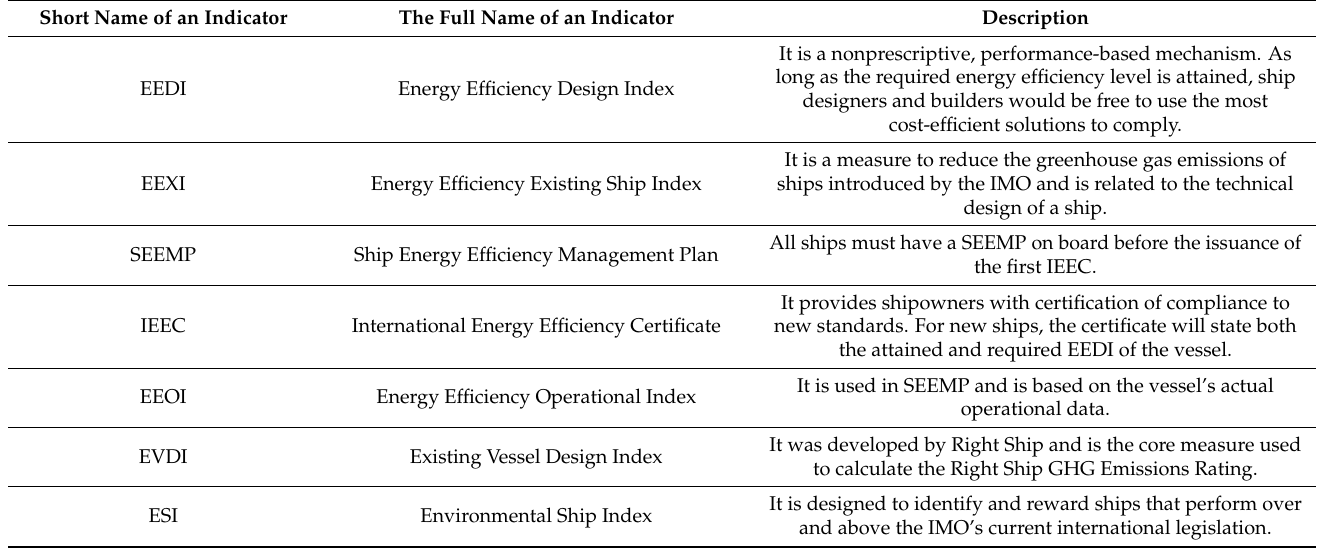
Table 1. Indicators used to monitor greenhouse emissions and energy efficiency in the maritime